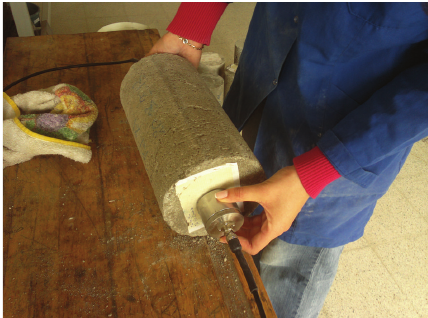
Figure 4: Ultrasonic pulse velocity measurement.